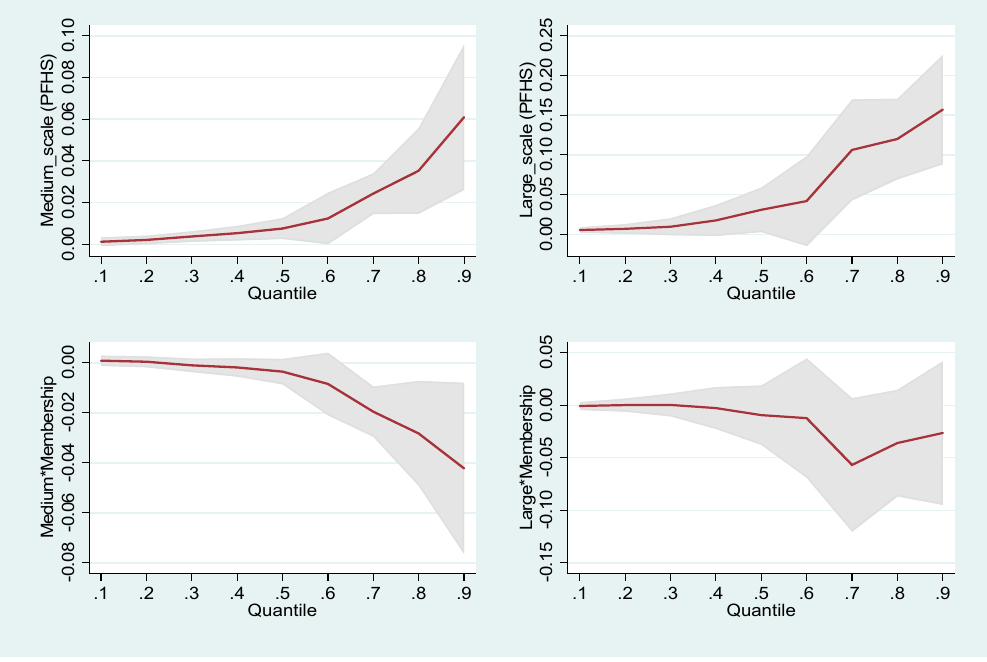
Figure 2. Quantile regression, farm size categorized by Primary Farm Household Survey (PFHS) criterion.